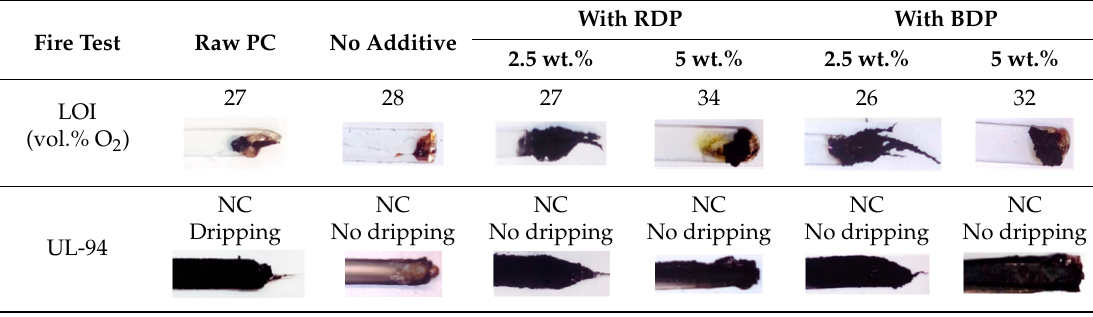
Table 4. LOI, UL-94 rating for PC, and coated PC with the binary and ternary mixtures.